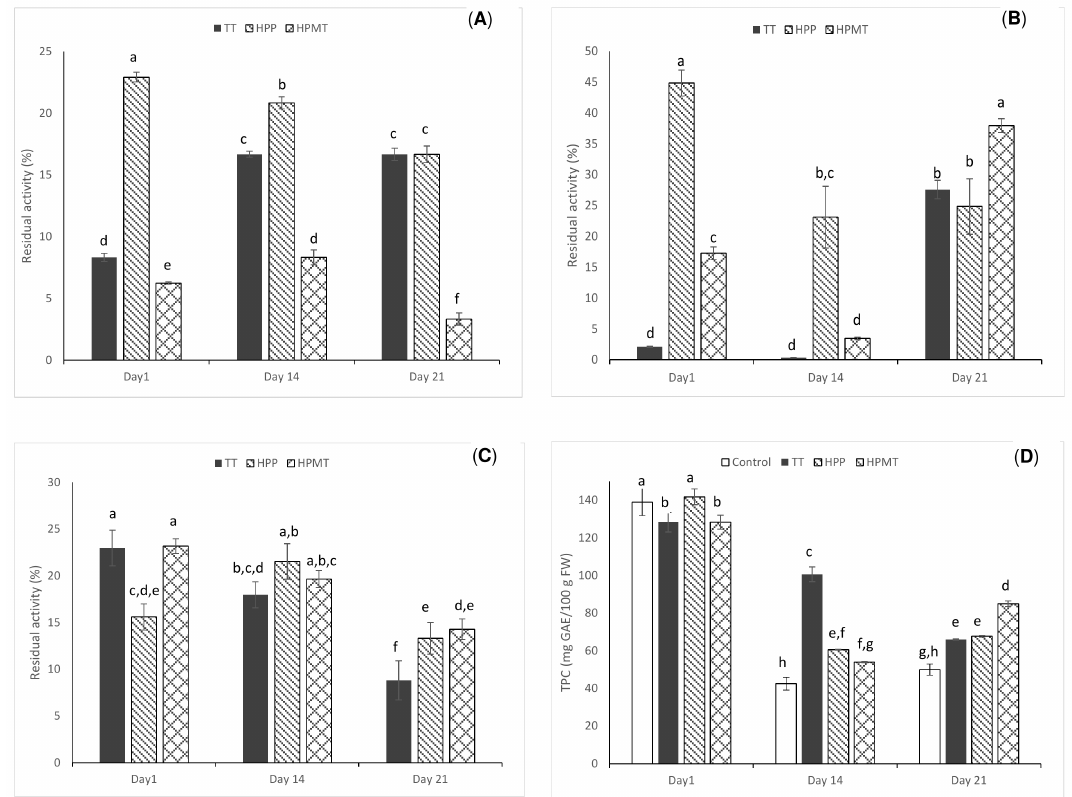
Figure 1. The stability of peach–strawberry puree TT (70 ◦ C, 15 min), HPP (600 MPa, 10 min) and HPMT (600 MPa, 50 ◦ C, 10 min) treated during refrigerated storage: ( A ) the residual activities of polyphenol oxidase (PPO); ( B ) the residual activities of peroxidase (POD); ( C ) the antiradical activity (DPPH) and ( D ) on the total polyphenol concentration (TPC). The error bars represent the standard deviation calculated on the average of three replicate samples. Different letters on each bar represent significant differences given by ANOVA and Tukey post hoc test ( p <